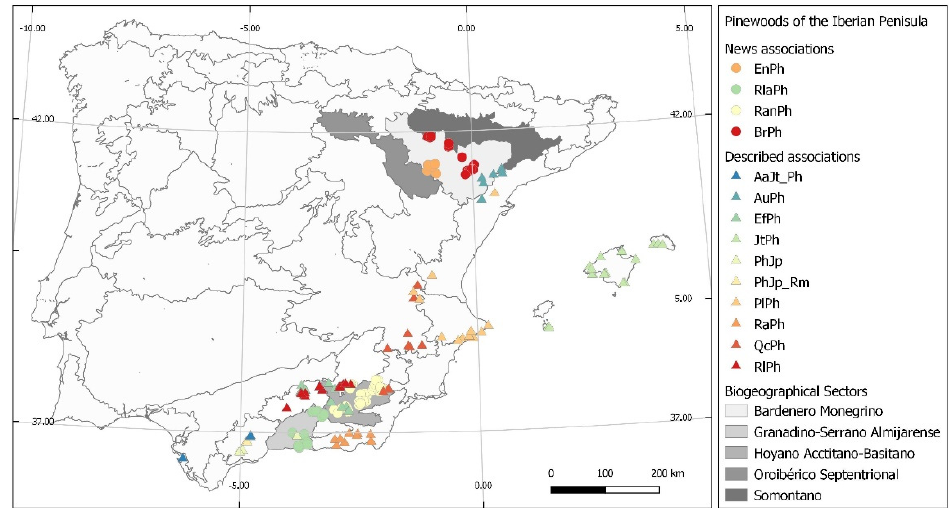
Figure 3. Biogeographical location of the associations in the study. Br. Bupleuro rigidi-Pinetum halepensis ; EnPh. Ephedro nebrodensis-Pinetum halepensis ; RanPh. Rhamno angutifoliae-Pinetum halepensis ; RlaPh. Rhamno laderoi-Pinetum halepensis ; AaJt_Ph. Asparago-Juniperetum turbinatae pinetosum halepensis ; AuPh. Arbuto unedonis-Pinetum halepensis ; EfPh. Ephedro fragilis-Pinetum halepensis ; JtPh. Junipero turbinatae-Pinetum halepensis ; PhJp. Pino halepensis-Juniperetum phoeniceae ; PhJp. Pino halepensis- Juniperetum phoeniceae rhamnetosum myrtifoliae ; PlPh. Pistacio lentisci-Pinetum halepensis ; QcPh. Querco cocciferae-Pinetum halepensis ; Rhamno almeriensis-Pinetum halepensis ; RlPh. Rhamno lycioidis-Pinetum halepensis